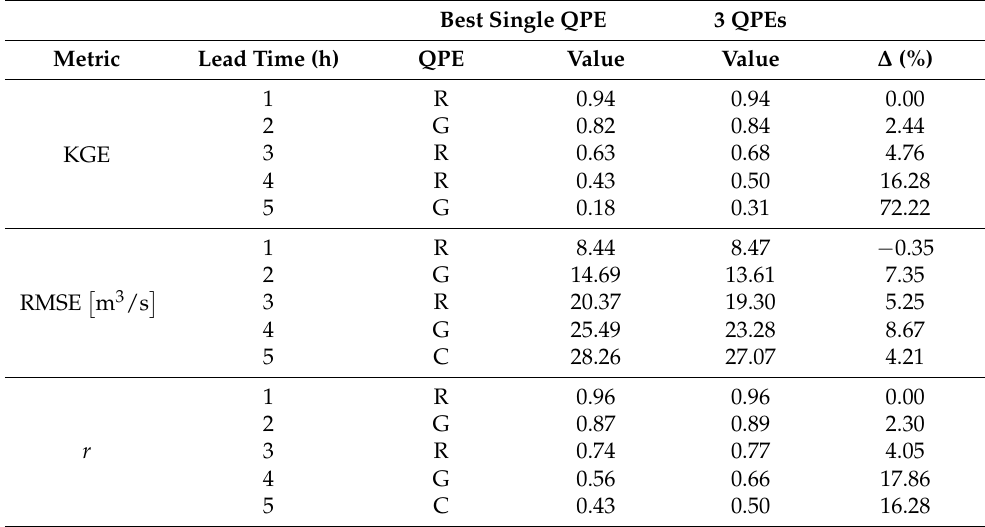
Table 3. Summary of mean performance gains for metrics related to goodness of fit when comparing single-QPE ML models with three-QPEs ML models. Best Single QPE 3 QPEs Metric Lead Time (h)